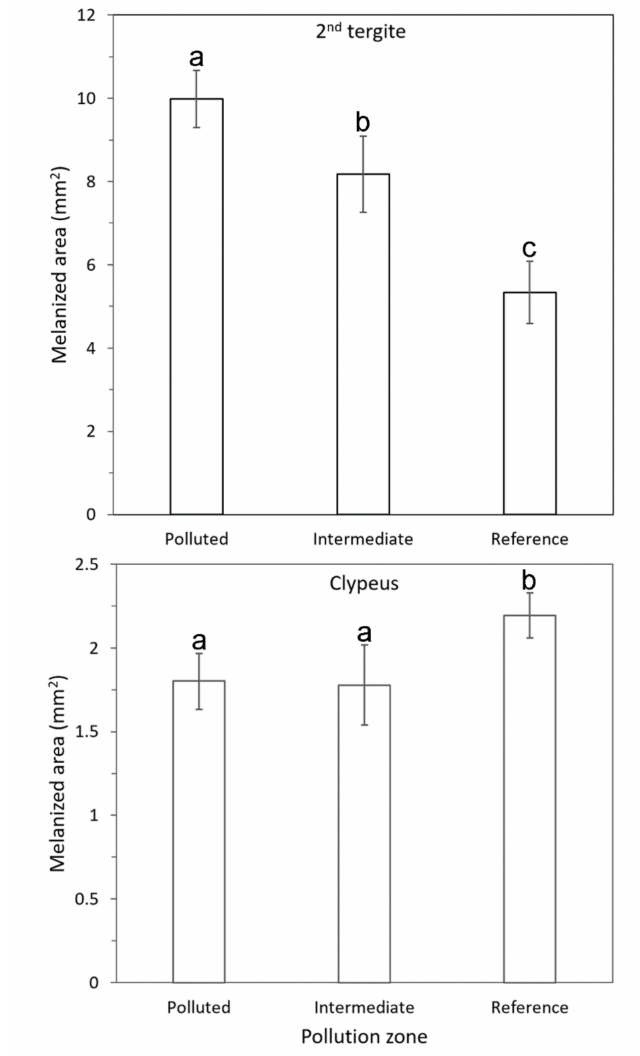
Figure 5. Mean size ( ± 95% CI) of the melanized marking in the clypeus and second tergite in the three pollution zones. A different letter above the bars indicates a significant pairwise difference (Tukey’s test p <